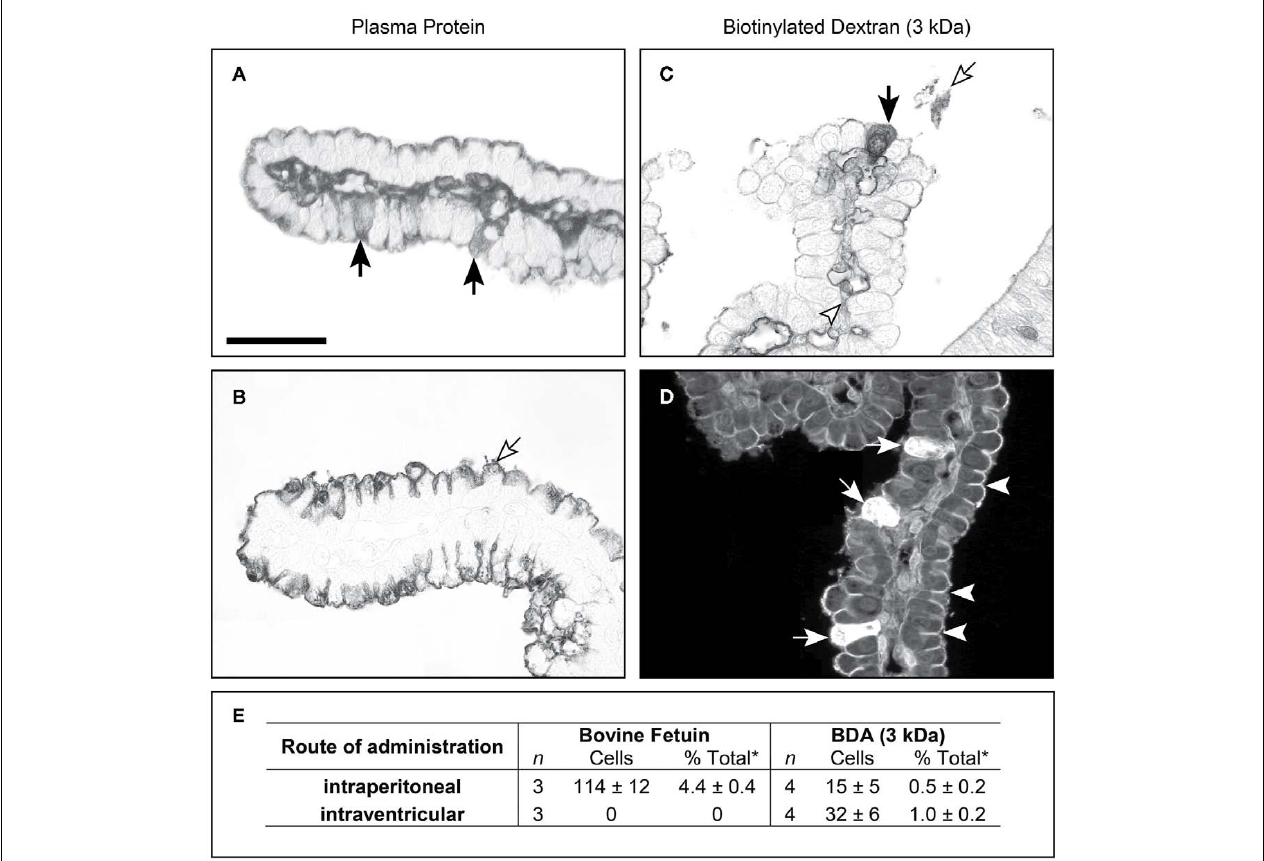
vessel lumen (arrowhead) and precipitated in the CSF (unfilled arrow). (D) Ten minutes after intraventricular injection with Fluorescein-conjugated BDA (3kDa), more epithelial cells take up the probe (filled arrows) following CSF injection compared with intraperitoneal injection (C) . Penetration of the fluorescent probe between epithelial cells is stopped by the presence of tight junctions (examples highlighted by arrowheads). (E) Uptake of bovine fetuin and BDA (3kDa) into choroid plexus epithelial cells in P9 Monodelphis following intraperitoneal or intracerebroventricular injection; mean ±